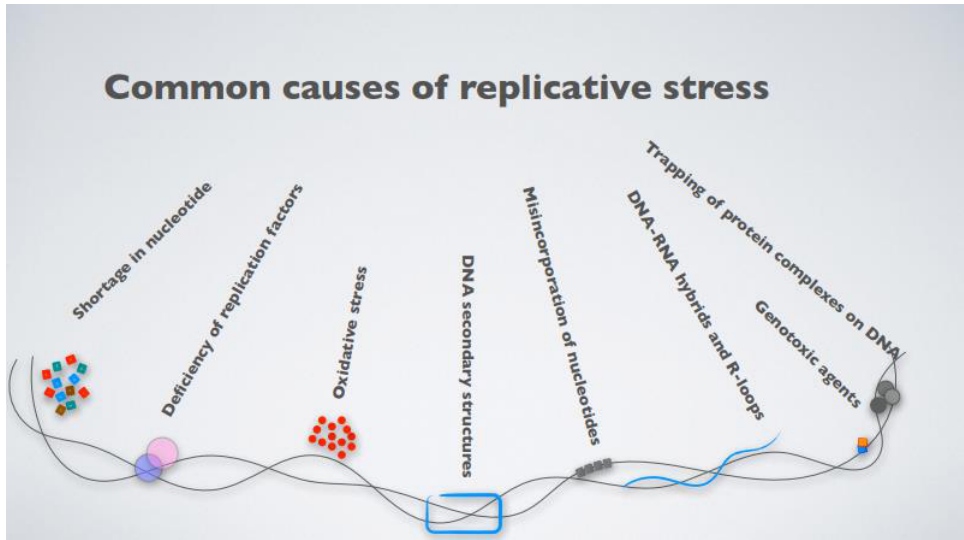
Figure 1. The most common causes contributing to cellular replicative stress. The induction of DNA double-strand breaks (DSBs) following activation of many oncogenes is the result of their ability to lead to the pervasive formation of stalled forks which eventually collapse [31]. Several mechanisms can contribute to oncogene-induced DNA replicative stress. For example, activation of oncogenic RAS driving proliferation and cell growth increases the number of active replicons and leads to asymmetric fork progression [28]. It should be noted that RAS, like other oncogenes, might elicit the fork stalling through additional mechanisms. RAS, for example, also suppresses nucleotide metabolism by downregulating the ribonucleotide reductase subunit M2 (RRM2), a rate-limiting protein in dNTP synthesis, and causing dNTP pool depletion and prema- ture termination of replication forks [37]. Moreover, RAS overexpression leads to in- creased global transcription activity to face the additional demands stemming from the increased proliferation [38], which is then linked to replicative stress due to R-loop ac- cumulation and increased expression of the general transcription factor TBP [38]. The oncogene MYC, as well, induces replicative stress through various mechanisms. MYC overexpression causes the direct deregulation of DNA replication dynamics due to interaction with members of the DNA replication machinery [39 – 42]. Additionally, MYC is a transcription factor that controls the expression of a large fraction of cellular genes linked to cell cycle control. MYC may promote cell cycle progression and replicative stress through indirect mechanisms, by regulating the expression of genes involved in cellular proliferation [43] and DNA replication, including the majority of genes involved in the nucleotide biosynthesis pathway [44]. Finally, MYC also induces replicative stress through the generation of TRCs [44]. There are also additional mechanisms by which oncogenes may induce replicative stress. Aberrant oncogene expression results in the loss of redox homeostasis with the unbridled generation of ROS [45]. Accumulation of ROS leads to the formation of 8-oxoguanine, and the resulting oxidative DNA damage causes the replication fork to stall at lesions, ultimately promoting replicative stress in cancer cells [42,46,47]. Finally, the induction of DNA DSBs can also be observed when tumor suppressors are lost. The deregulated activity of pRB, p53, p16, and p14 ARF have been linked to repli- cative stress through various mechanisms that result in the promotion of G1-S transition [48].